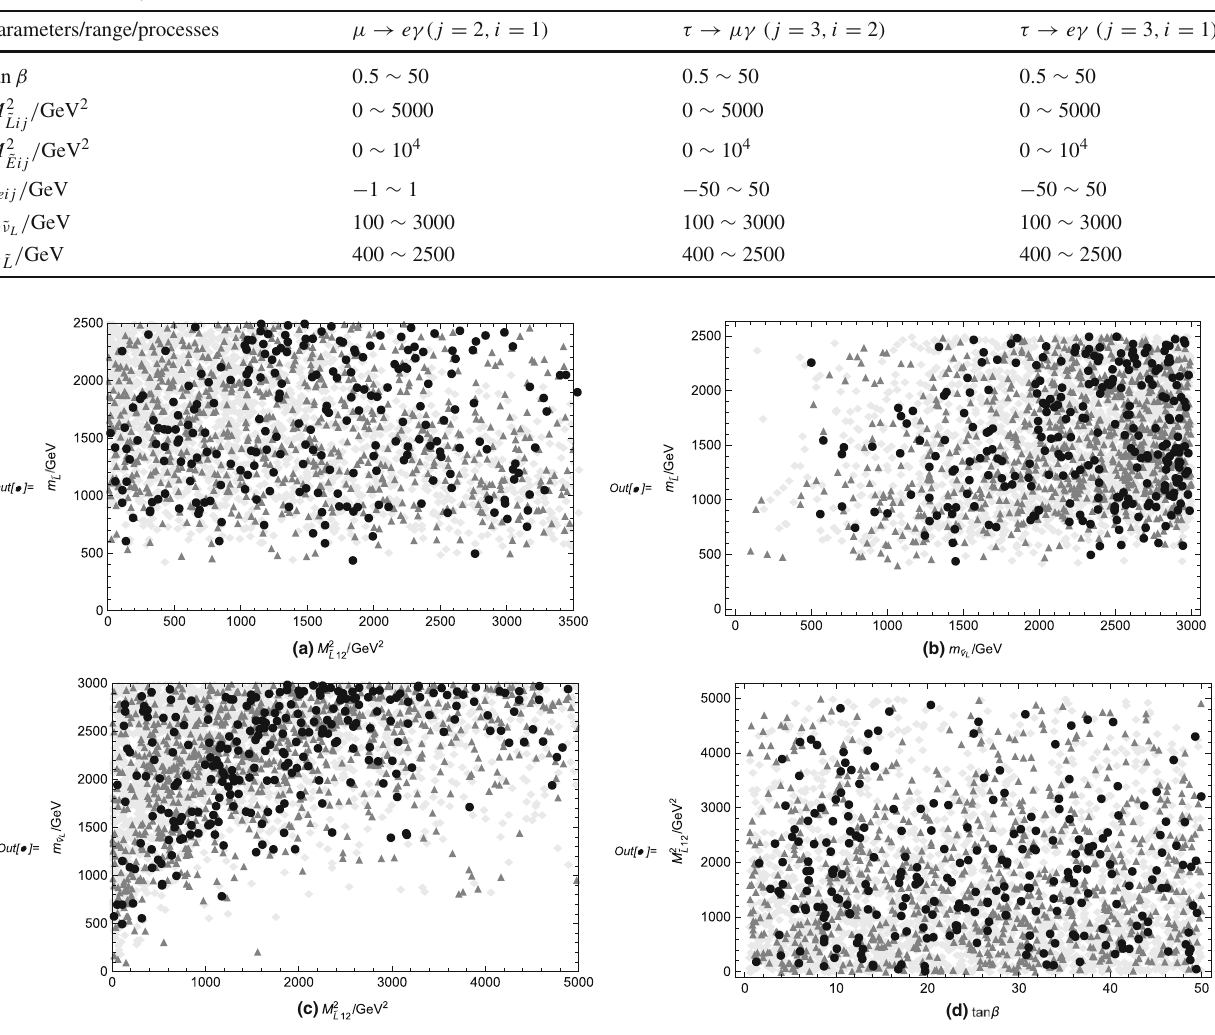
Fig. 8 Under the premise of lower current limit on lepton flavor vio- lating decay μ → e γ , reasonable parameter space is selected to scatter points, where (cid:2) mean the value of Br (μ → e γ) less than 1 . 5 × 10 − 13 ,